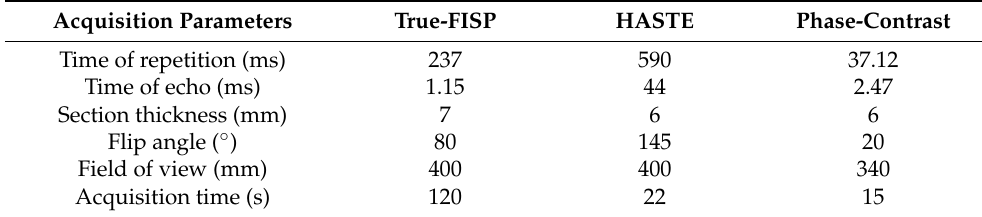
Table 1. MRI acquisition